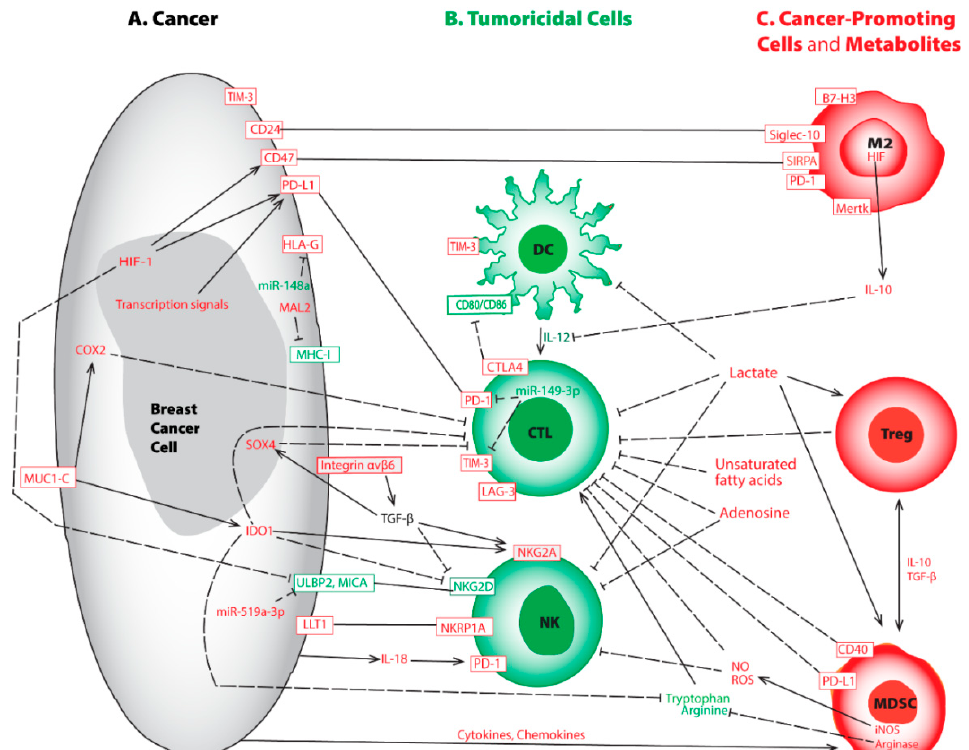
Figure 1. Representative aberrations in breast cancer cell ( A ), tumoricidal cells ( B ), cancer ‐ promoting cells and metabolites ( C ) lead to immune evasion. This crosstalk map indicates the tumoricidal cells and factors (in green) and the pro ‐ tumorigenic counterparts and factors (in red). Rectangular boxes represent cell surface molecules; plain lines indicate binding; solid arrows represent activation; and dashed lines show inhibition between modulators. Abbreviations used include cluster of differentiated (CD), CTL ‐ associated protein 4 (CTLA ‐ 4), cyclooxygenase ‐ 2 (COX2), cytotoxic T lymphocyte (CTL), dendritic cell (DC), human leukocyte antigen G (HLA ‐ G), hypoxia ‐ inducible factor (HIF), indoleamine 2,3 ‐ dioxygenase (IDO), inducible nitric oxide synthase (iNOS), interleukin (IL), lymphocyte activation gene ‐ 3 (LAG ‐ 3), lectin ‐ like transcript ‐ 1 (LLT1), M2 macrophage (M2), myelin and lymphocyte protein 2 (MAL2), major histocompatibility complex class I (MHC ‐ I), myeloid ‐ derived suppressor cells (MDSC), macrophage c ‐ mer tyrosine kinase (Mertk), major histocompatibility complex (MHC), MHC ‐ I related chain A (MICA), mucin 1 C ‐ terminal (MUC1 ‐ C), natural killer cell (NK), nitric oxide (NO), reactive oxygen species (ROS), regulatory T cell (Treg), programmed death receptor ‐ 1 (PD ‐ 1), programmed death ‐ ligand 1 (PD ‐ L1), sialic acid binding Ig like lectin ‐ 10 (Siglec ‐ 10), signal regulatory protein α (SIRPA), T ‐ cell immunoglobulin and mucin domain ‐ containing molecule 3 (TIM ‐ 3), transforming growth factor β (TGF ‐β ), and UL16 binding protein 2 (ULBP2). It is worth mentioning the sizes of various cells may be disproportional to their actual dimensions.